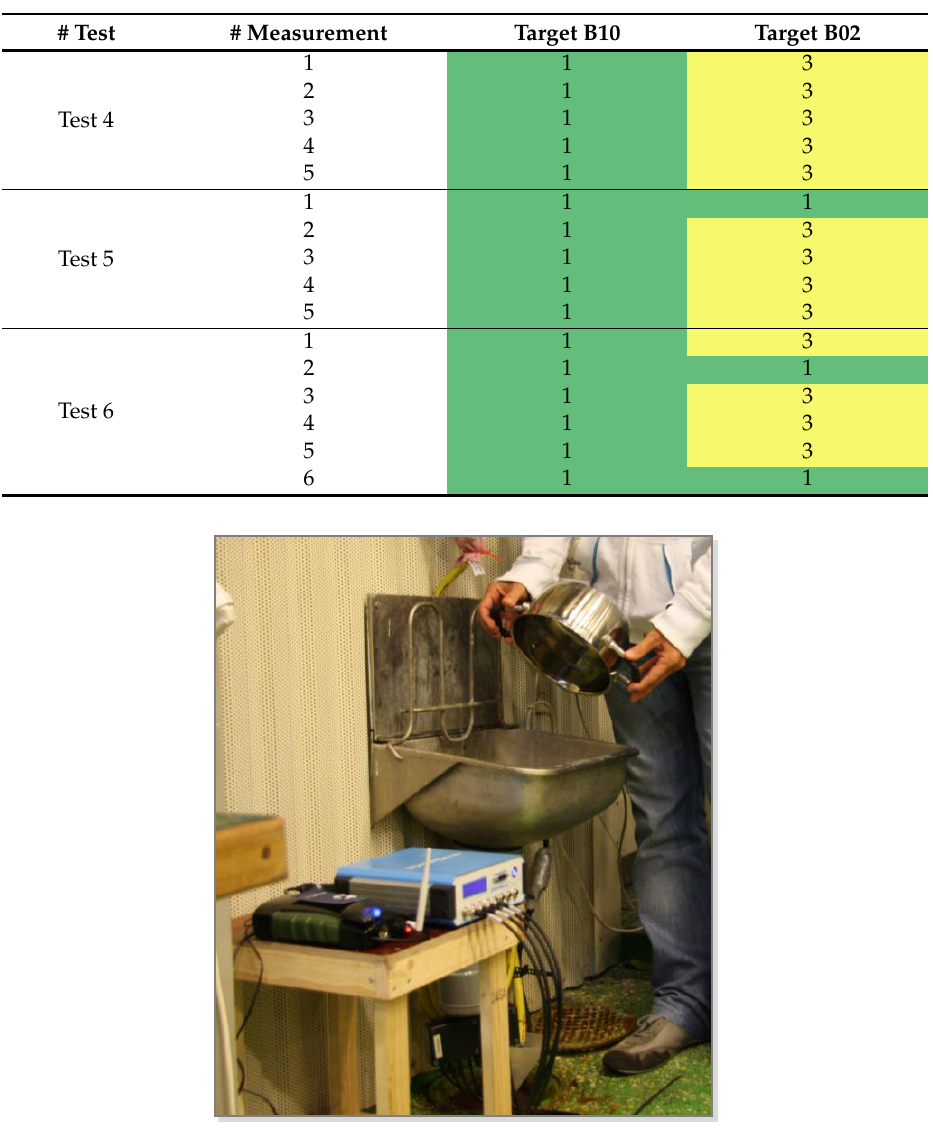
Table 11. Results of the three tests performed at FOI for target B02.